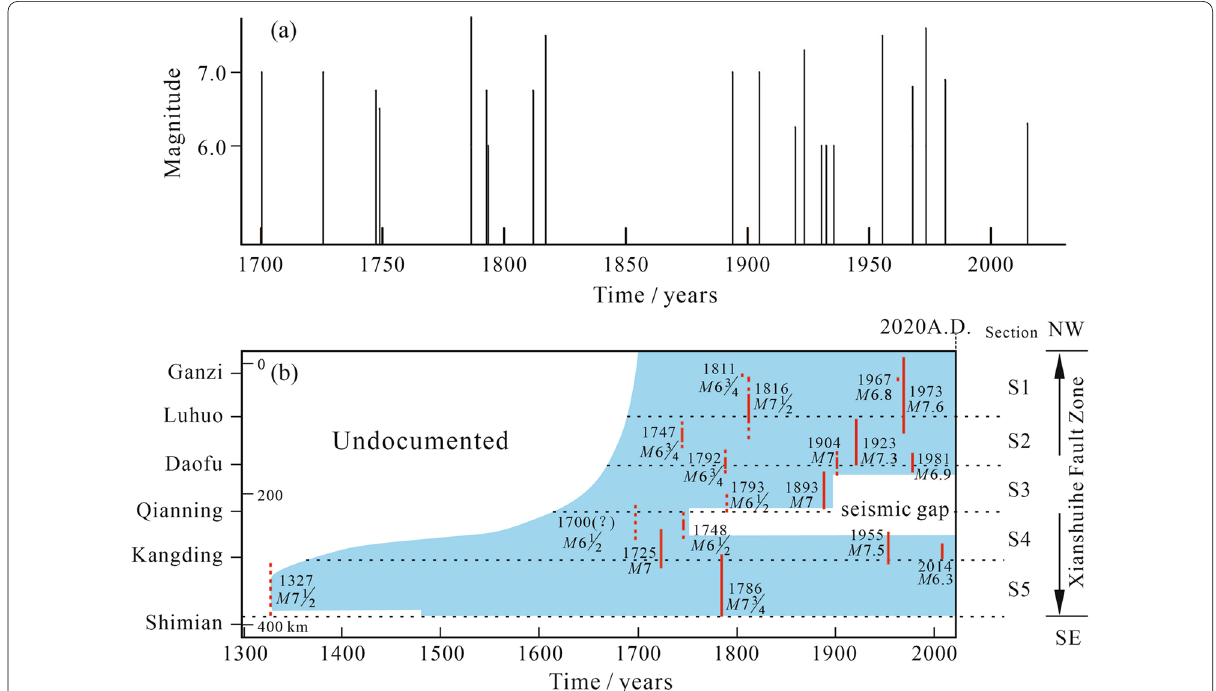
Fig. 2 Historical seismicity of the Xianshuihe Fault Zone. a M earthquakes in the Xianshuihe Fault Zone since 1300 ( modified from Wen et al. (2008)). Reliability of rupture determination: the vertical red solid line > the vertical red dotted lines at both ends > the red dotted